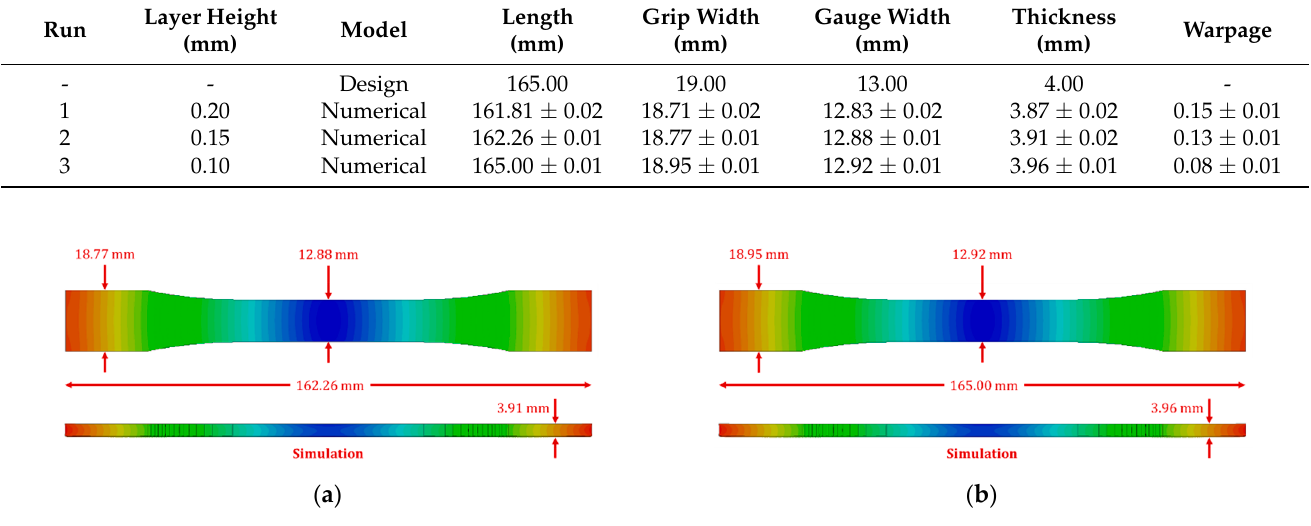
Figure 6. Specimen dimensions for numerically predicted 3D printed at different layer heights: ( a ) 0.15 mm, ( b ) 0.10 mm.